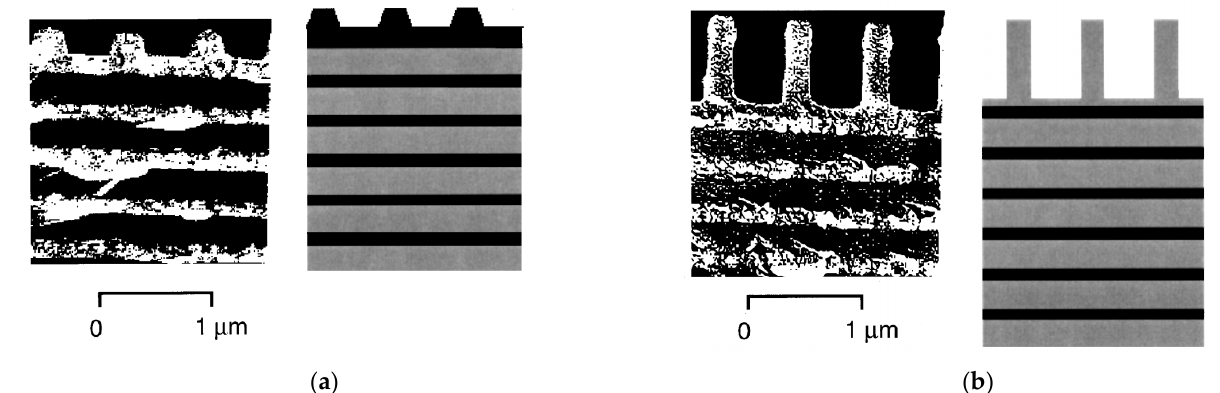
Figure 7. Multilayer dielectric designs of high ‐ index (H) and low ‐ index (L) layers, showing relative locations of substrate, multilayers, and groove corrugations (G). ( a ) Overcoated grating; dielectric layers effectively form a volume grating. ( b ) Undercoated grating; layers form a high ‐ reflectivity (HR) stack under the corrugations.